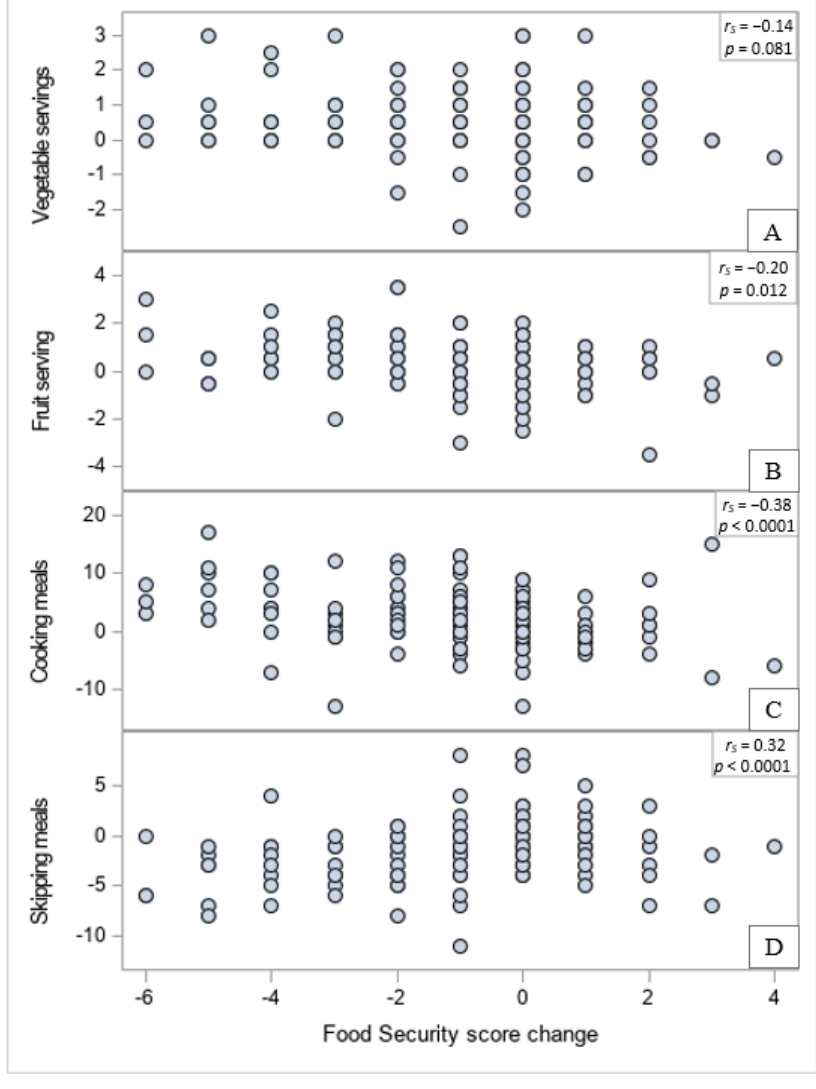
Figure 2. Scatter plots and Spearman correlations ( r S and p -values) between previously reported changes in vegetable intake (A), fruit intake (B), cooking frequency (C), skipping meals frequency (D) and changes in food security scores ( n = 149).